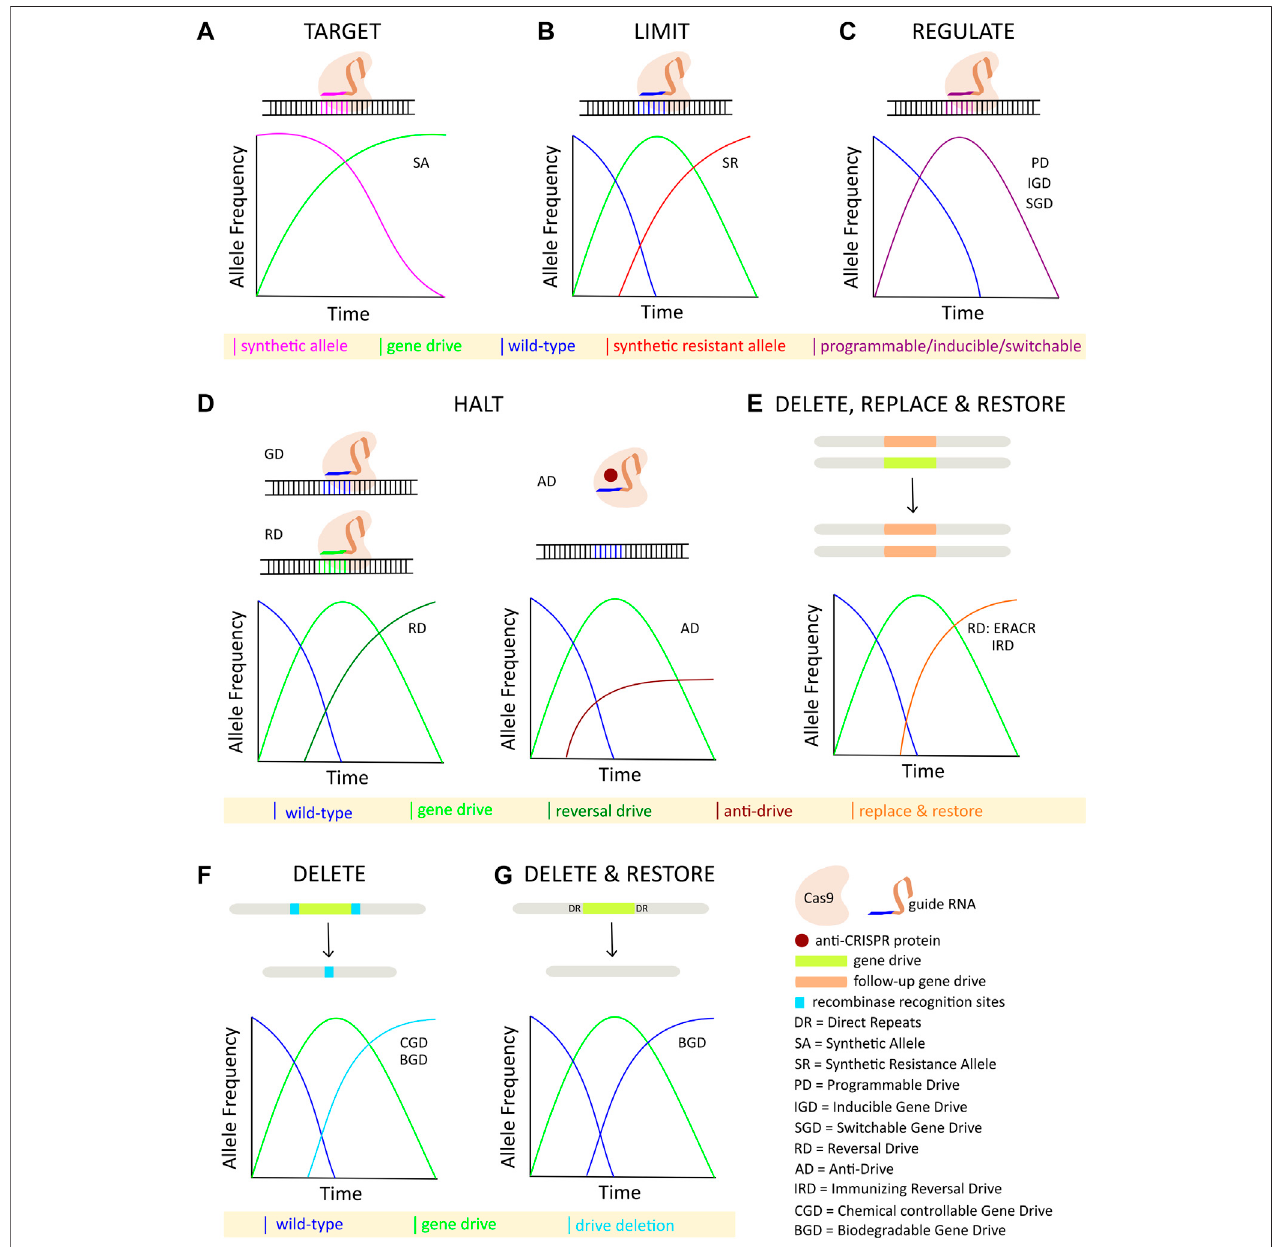
FIGURE 2 | Overview of strategies for controlling CRISPR-based autonomous homing gene drives: (A) Synthetic target sites are speci fi cally cleaved and homed into by the autonomous drive element. (B) Inundation with synthetic resistant alleles limits the spread of an autonomous drive. (C) Titration and/or induction of various programmable, inducible, or switchable components of the autonomous drive regulate its spread. (D) Spread of autonomous drive is halted either by a second drive targeting the fi rst drive, or by a protein-based anti-Cas9 interaction. (E) Autonomous drive is deleted and replaced with a second element carrying a rescue gene. (F) Autonomousdriveisdeletedbyinducingrecombinationbetweentransgenictargetsites fl ankingthedriveallele. (G) Autonomousdriveisdeletedbyhomology-based intramolecular recombination leading to restoration of the native wild-type alleles.